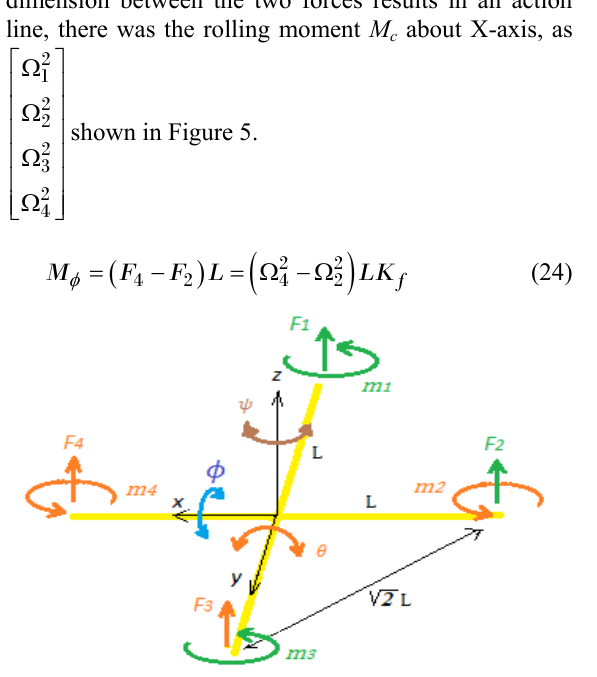
Figure 6. Plus-quadcopter general